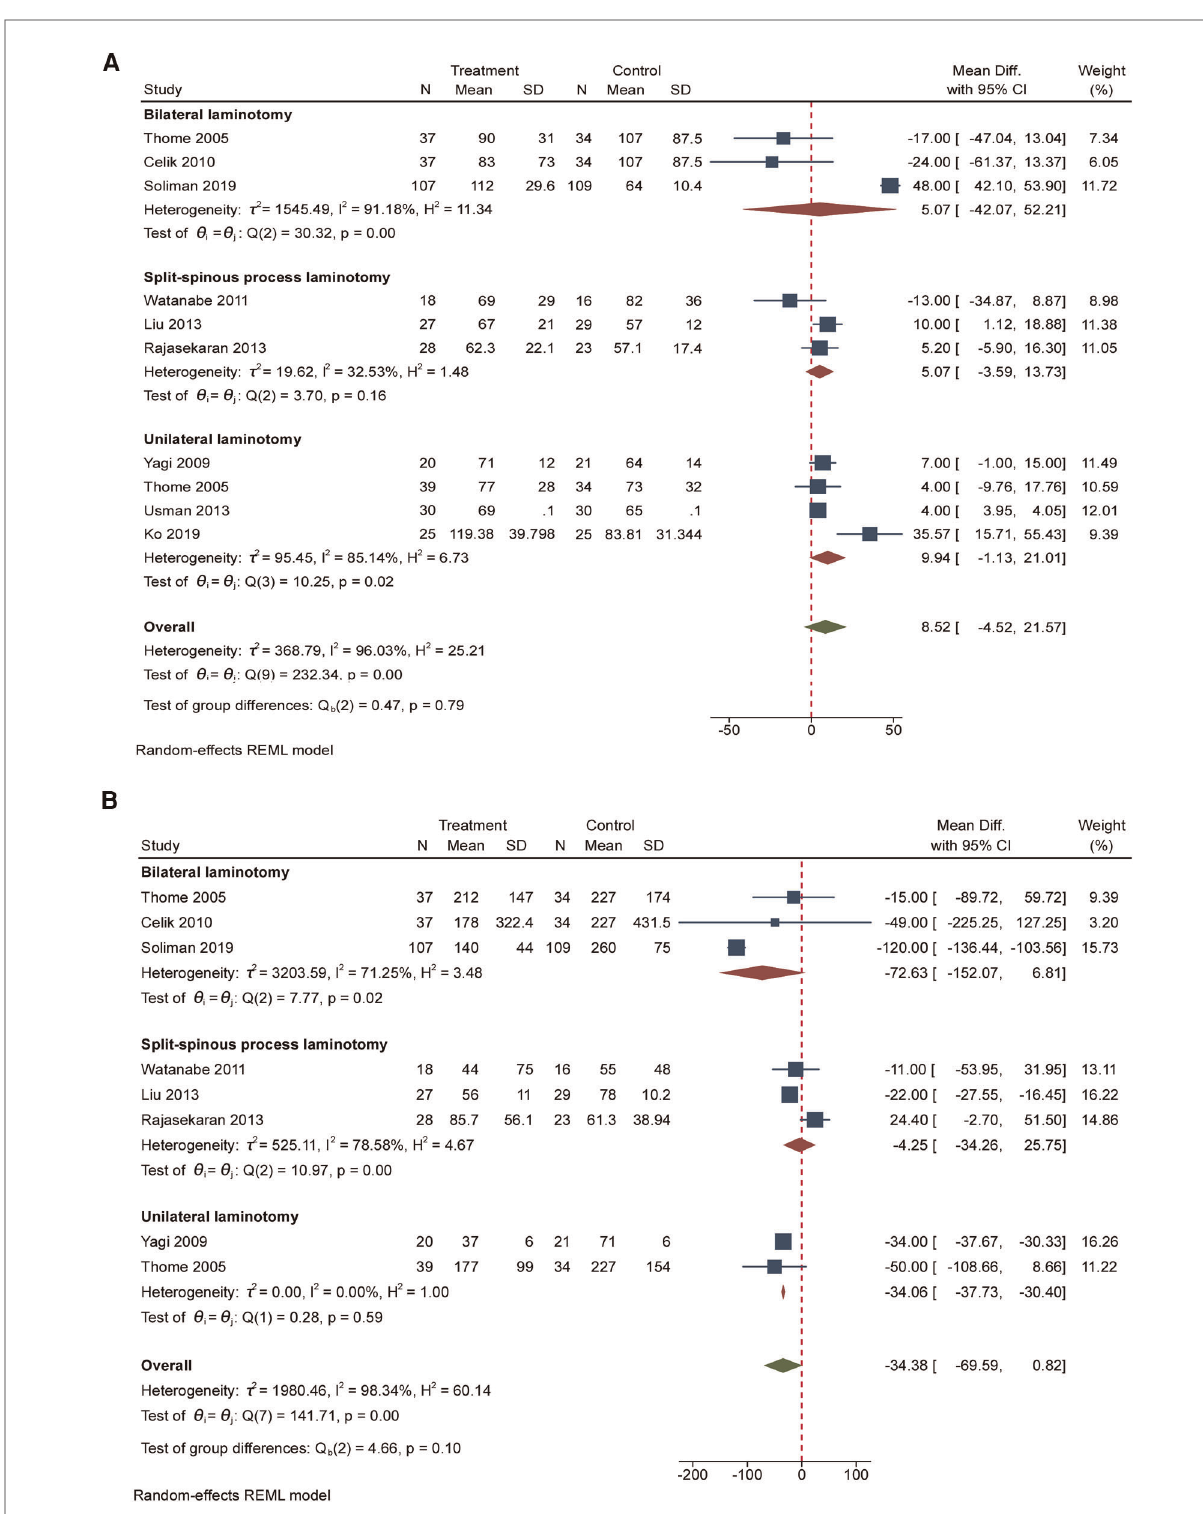
FIGURE 6 ( A ) The forest plot regarding instability compared posterior techniques with tourniquet group. ( B ) The forest plot regarding recovery (good+ excellent) compared posterior techniques with tourniquet